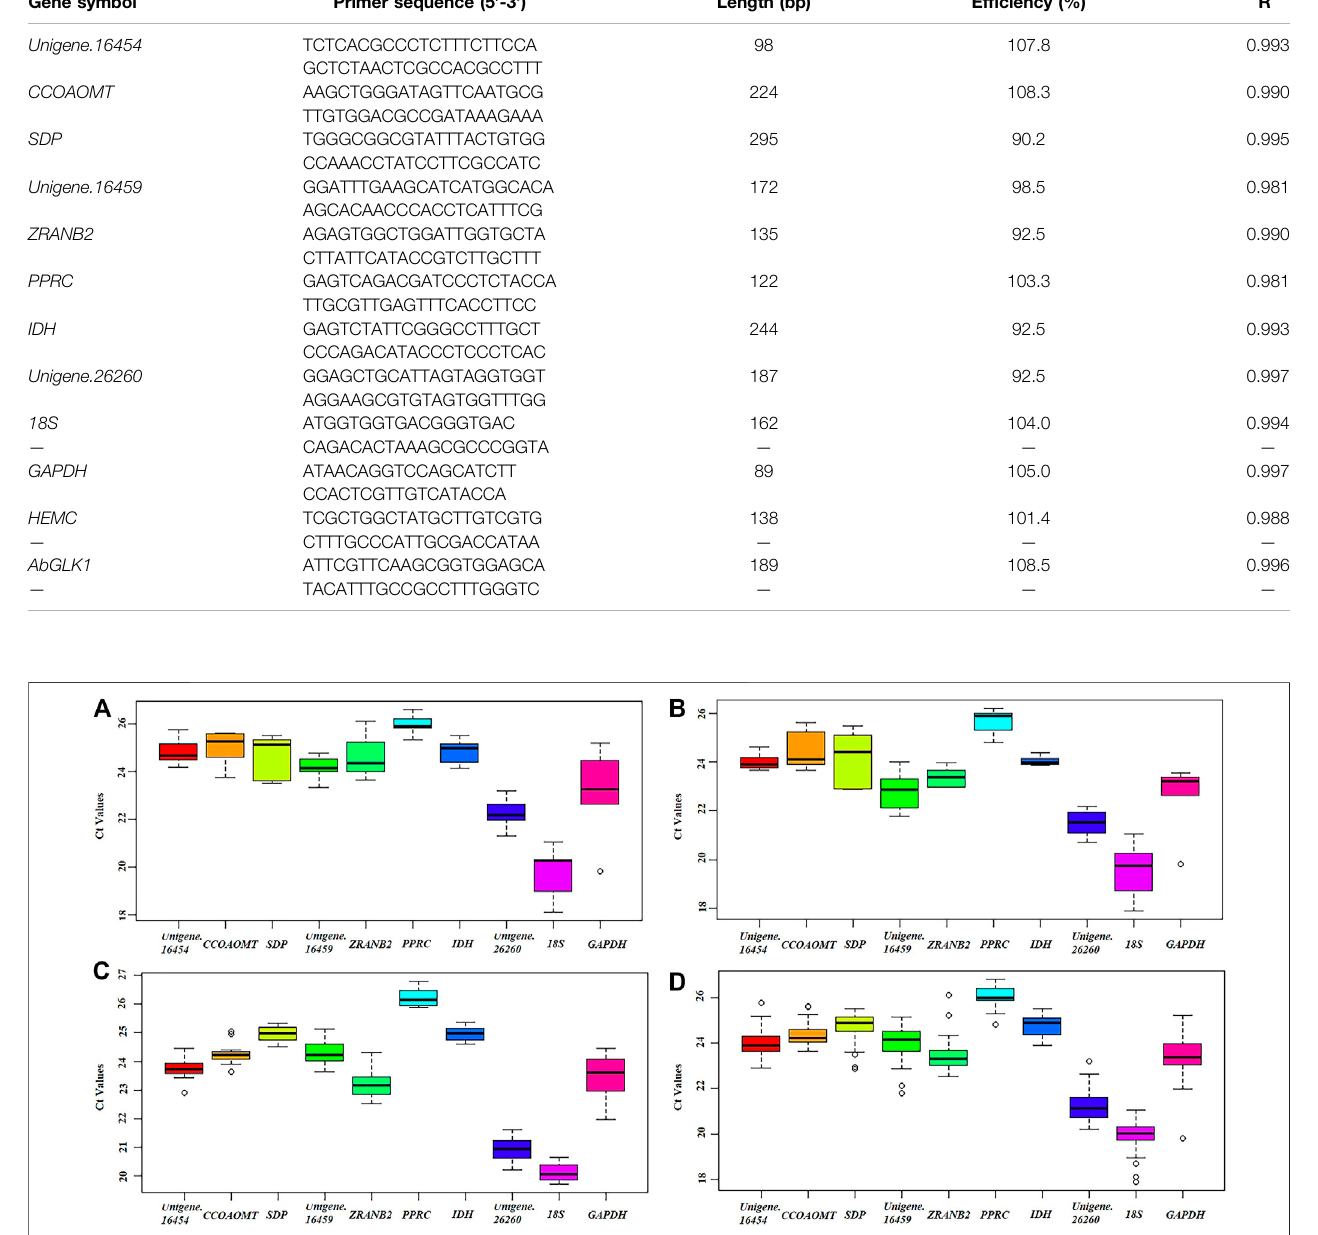
FIGURE3| DistributionofCqvaluesofcandidatereferencegenesinallsamples. (A) Tissue, (B) Developmentalstage, (C) Hormonetreatment, (D) Globalanalysis. Boxplots show the 25th and 75th percentiles, mean, and outliers.